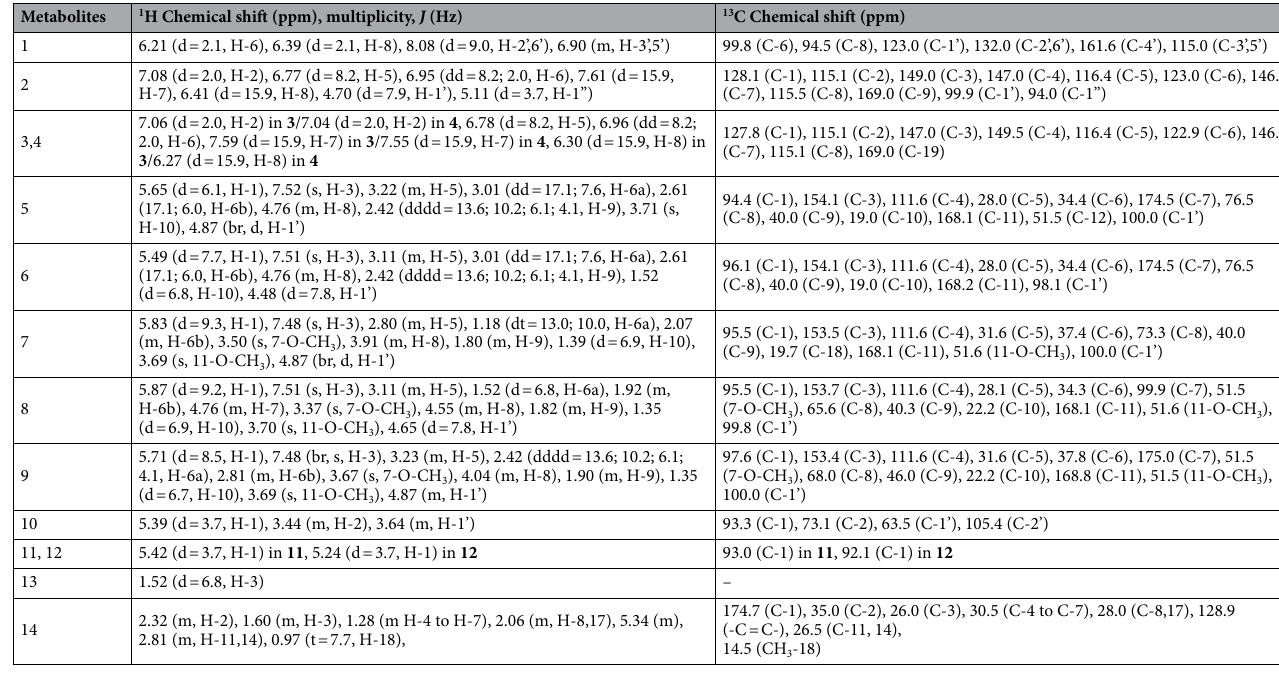
Table 2. Metabolites detected in intact leaf tissue of Citronella gongonha Mart. Howard (Cardiopteridaceae) by proton high-resolution magic angle spinning ( 1 H HR-MAS) nuclear magnetic resonance (NMR, 1 H 400.13 MHz; CD 3 OD as a magnetic field locking solvent), and structural elucidation by two-dimensional (2D) heteronuclear ( 1 H- 13 C) single quantum correlation (HSQC), long-range heteronuclear ( 1 H- 13 C) multiple bond correlation ( L-R J H-C HMBC) and double quantum filter homonuclear ( 1 H- 1 H) correlation spectroscopy (DQF-COSY) NMR ( 1 H 400.13- 13 C 100.6 MHz; CD 3 OD). Multiplicity: brd, broad doublet; brs, broad singlet; d, doublet; dd, doublet of doublets; dddd, doublet of doublet of doublet of doublets; dt, doublet of triplet; m, multiplet; s, singlet. Metabolites: 1 , kaempferol-3- O -dihexoside; 2 , caffeoyl glucoside; 3 , 3- O -caffeoylquinic acid; 4 , 5- O -caffeoylquinic acid; 5 , kingiside; 6 , 8-epi-kingisidic acid; 7 , (7 α )-7- O -methylmorroniside; 8 , (7 β )- 7- O -methylmorroniside; 9 ,